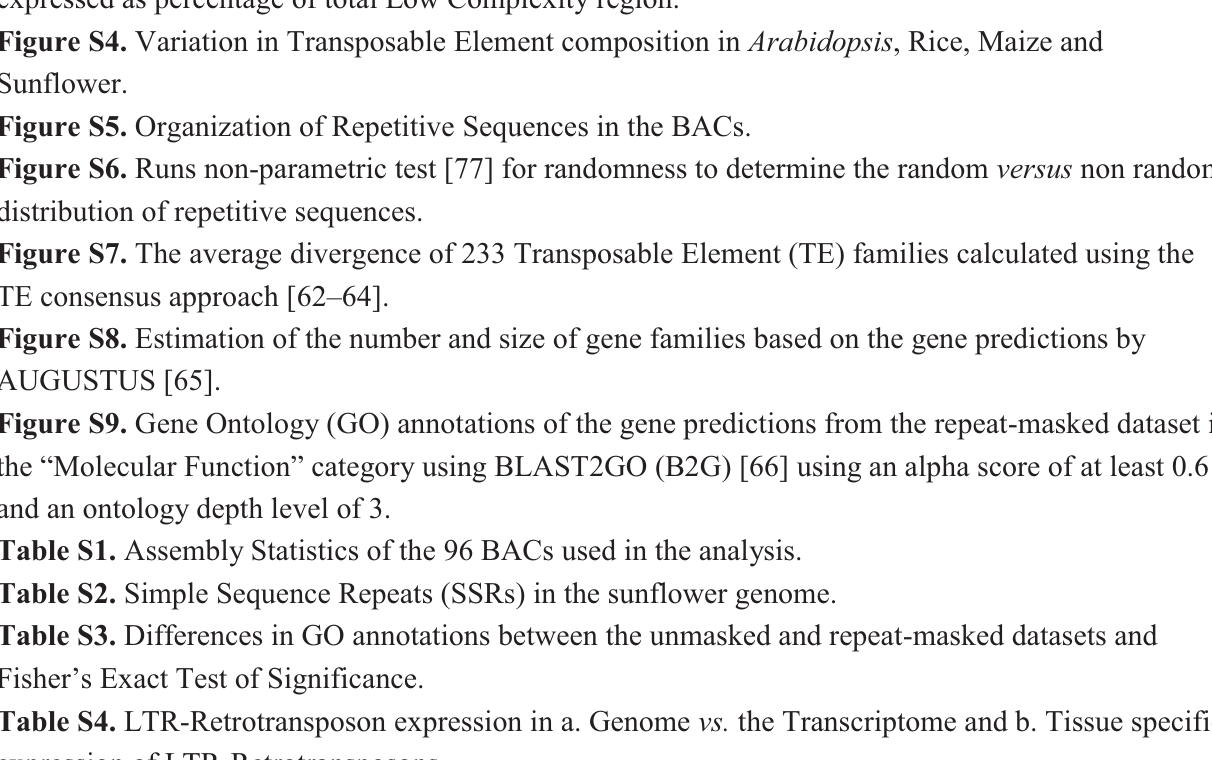
Figure S1. Copy Number Distribution of the Sunflower Repeat Families as identified by RECON [46]. Figure S2. Top 10 Simple Sequence Repeat (SSR) motifs arranged in order of their abundance in the sunflower genome. Figure S3. Different types of Low Complexity (LC) sequences identified in the sunflower genome expressed as percentage of total Low Complexity region. Figure S4. Variation in Transposable Element composition in Arabidopsis , Rice, Maize and Sunflower. Figure S5. Organization of Repetitive Sequences in the BACs. Figure S6. Runs non-parametric test [77] for randomness to determine the random versus non random distribution of repetitive sequences. Figure S7. The average divergence of 233 Transposable Element (TE) families calculated using the TE consensus approach [62 – 64]. Figure S8. Estimation of the number and size of gene families based on the gene predictions by AUGUSTUS [65]. Figure S9. Gene Ontology (GO) annotations of the gene predictions from the repeat-masked dataset in the “Molecular Function” category using BLAST2GO (B2G) [66] using an alpha score of at least 0.6 and an ontology depth level of 3. Table S1. Assembly Statistics of the 96 BACs used in the analysis. Table S2. Simple Sequence Repeats (SSRs) in the sunflower genome. Table S3. Differences in GO annotations between the unmasked and repeat-masked datasets and Fisher’s Exact Test of Significance. Table S4. LTR-Retrotransposon expression in a. Genome vs. the Transcriptome and b. Tissue specific expression of